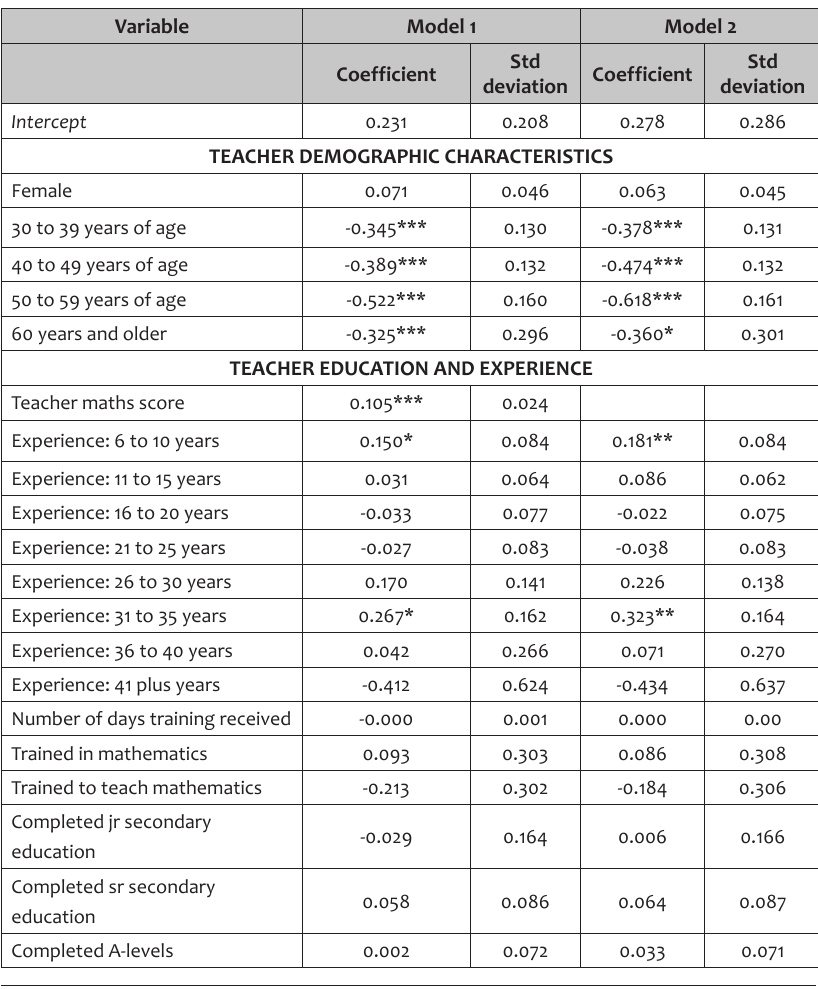
Table 1: Full hierarchical linear